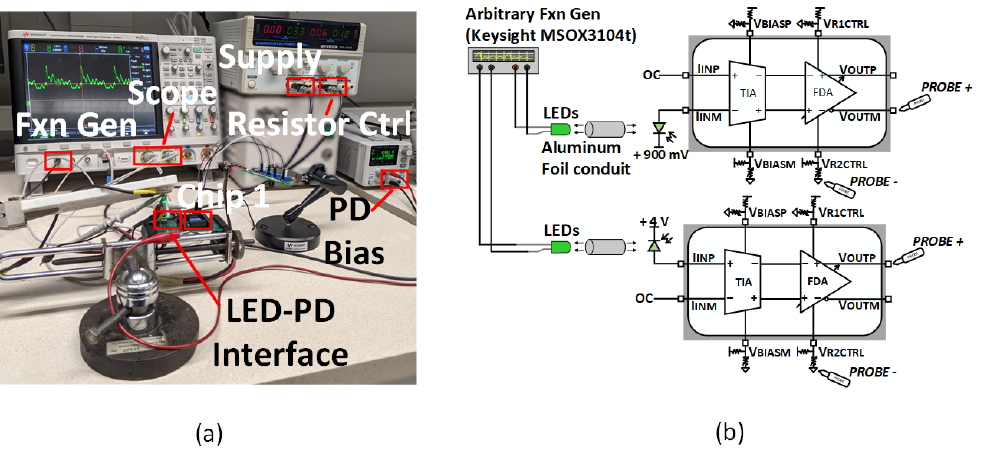
Figure 10. ( a ) Image of the testbench used for verification of AFE and LED driver functionality, ( b ) illustration of the testbench used for single-ended AFE